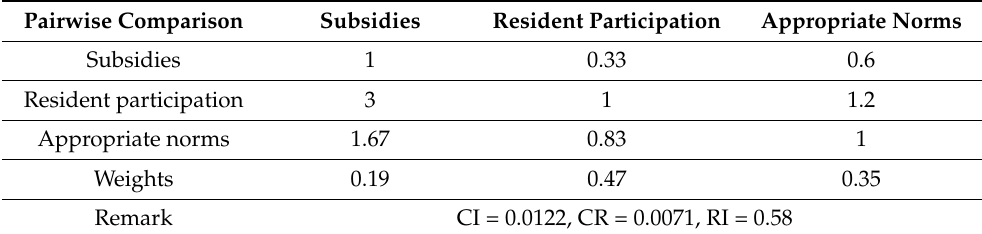
Table 5. Pairwise comparison of relative weights of factors at level 2-3.